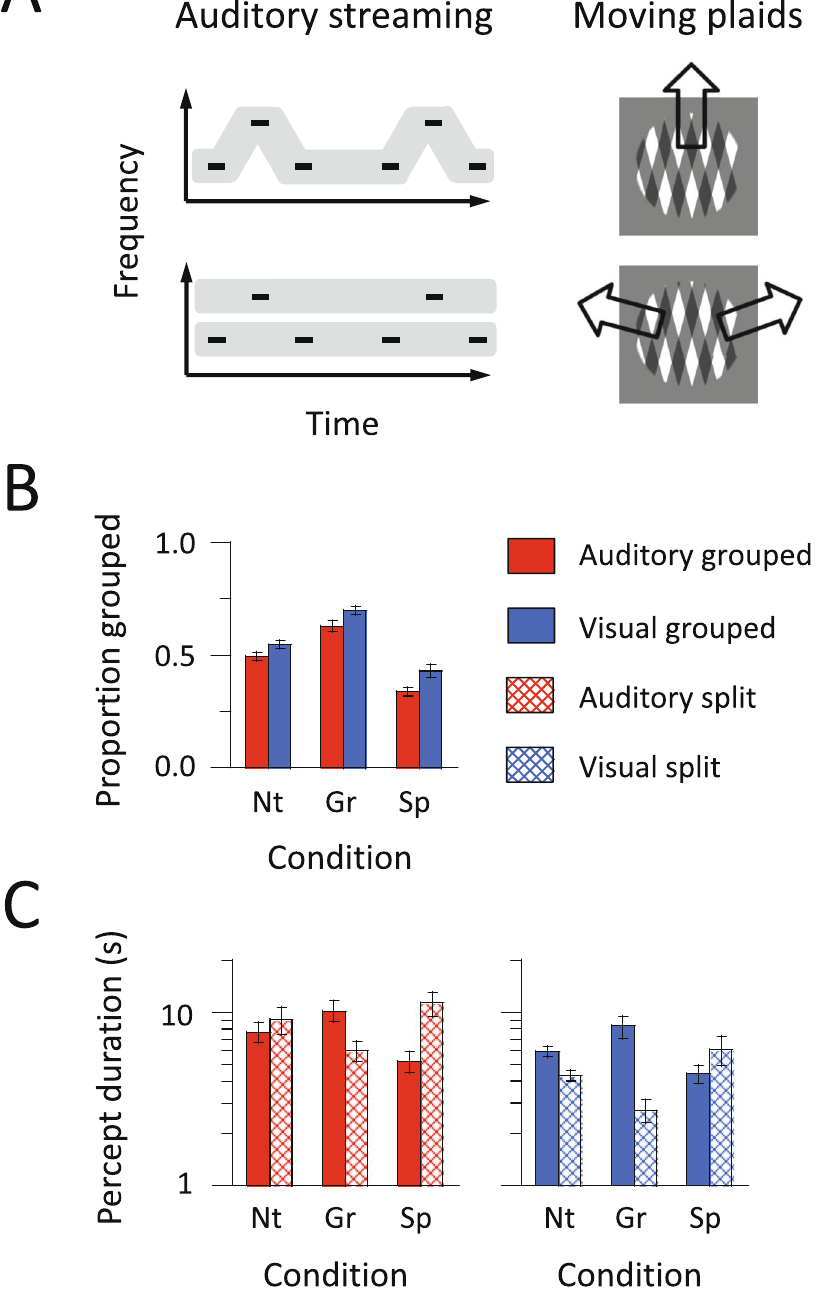
Figure 2. Stimuli and behavioural results for auditory and visual multistability. ( A ) Schematic representation of stimuli. A sound sequence of triplet tones was presented in auditory streaming. The auditory stimulus produces perceptual switches between one and two streams. Two rectangular gratings were moving in plaids. The visual stimulus induces perceptual switches between upward grouped and sideward split motion. ( B , C ) The average proportion of time spent in grouped percepts is shown as a function of condition (Neutral, Grouped, and Split) and input modality (auditory and visual presentation). Red and blue bars indicate the results for auditory streaming and moving plaids, respectively. The duration of alternating percepts is converted to a logarithmic scale for display purposes. Error bars represent the standard error of